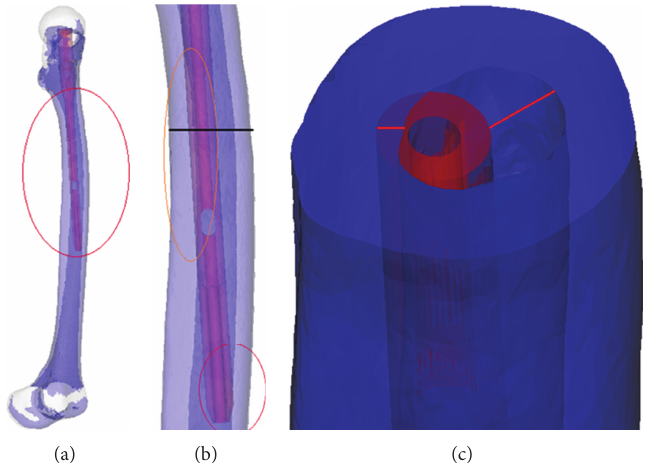
Figure3:ThemodelwasassembledbyPFNA-IIandfemur.(a)Theregionwithintheredcirclewastheregionofinterest.(b)Theimpingement area can be easily distinguished within the red circle, and the model was cut along the black line; (c) after the cut of the model, the maximum thickness of the impingement area and the distance from the inner cortex can be measured according to the direction of the red line. assess the statistical significance of the measurement